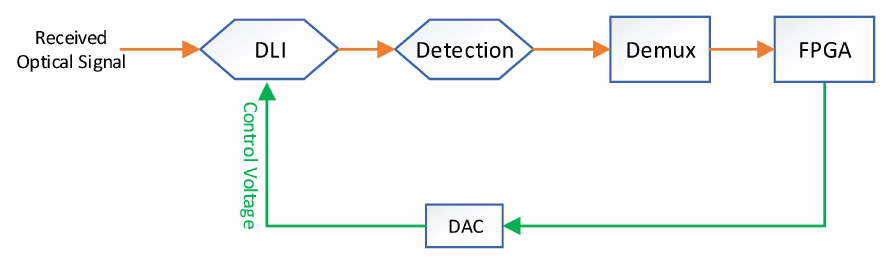
Figure 10. A DPSK receiver.